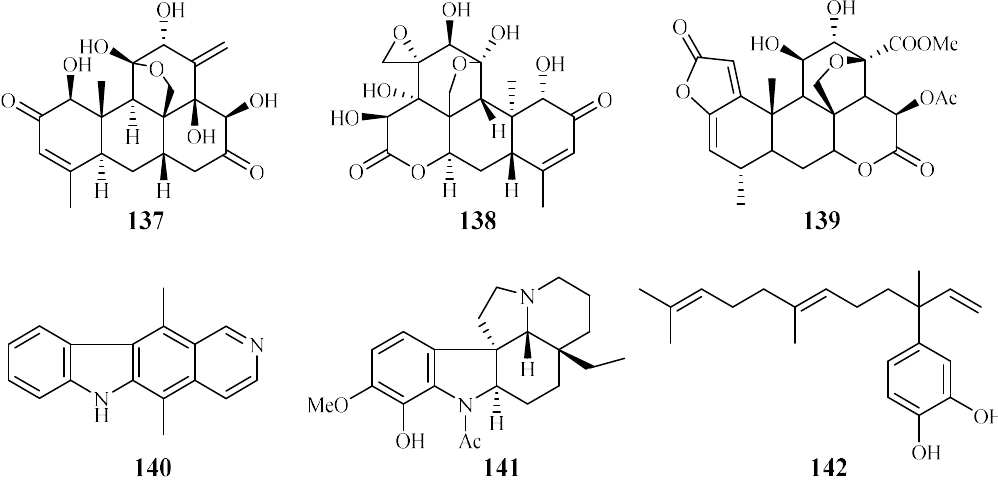
Figure 31. Compounds from Simaroubaceae plants.